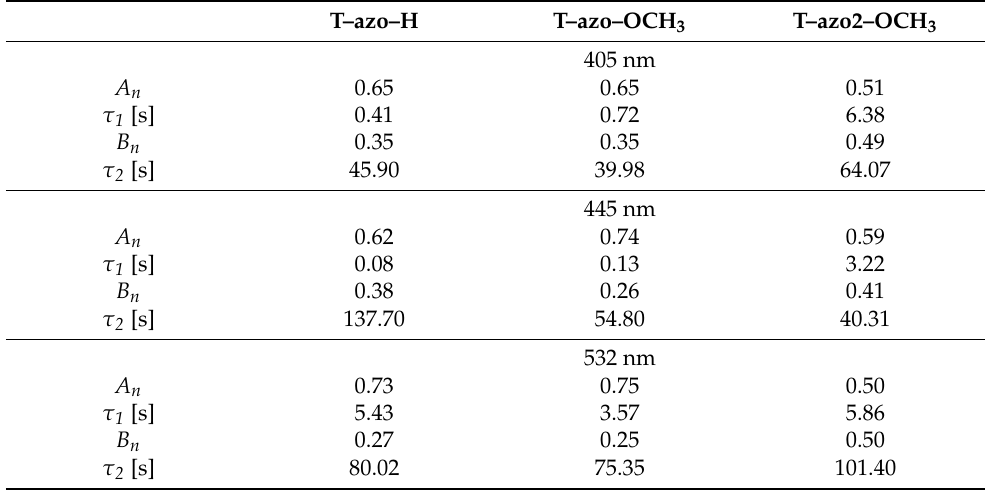
Table 1. Fitted parameters for the birefringence growths of T–azo–H, T–azo–OCH 3 and T–azo2– OCH 3 for 405 nm, 445 nm and 532 nm.